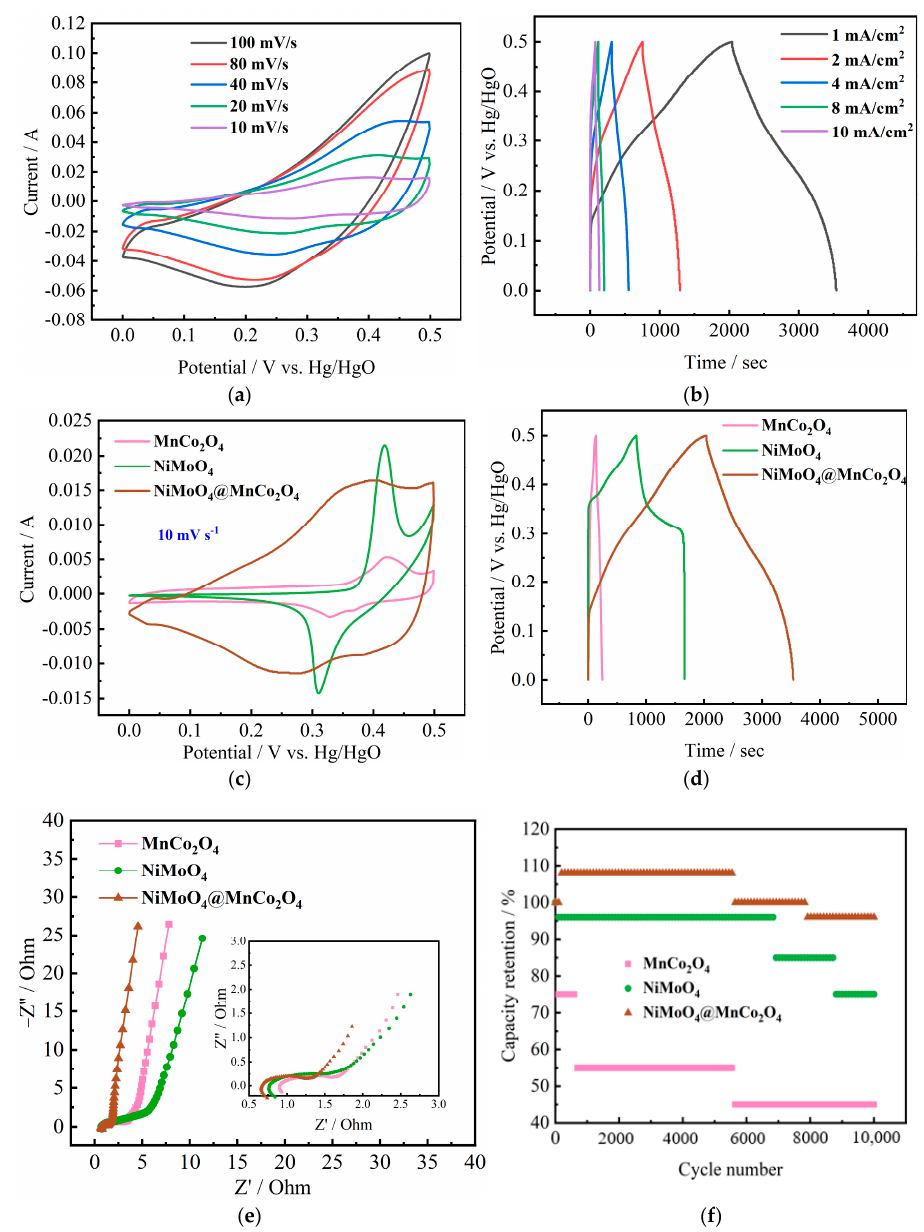
Figure 5. Electrochemical tests of three electrode materials: ( a ) CV curves of NiMoO 4 @MnCo 2 O 4 ; ( b ) GCD curves of NiMoO 4 @MnCo 2 O 4 ; ( c ) CV curves of three electrode materials; ( d ) GCD curves of the three electrode materials; ( e ) EIS curves of the three electrode materials (inset is the high-frequency region); ( f ) Long cycle curves of the three electrode materials.